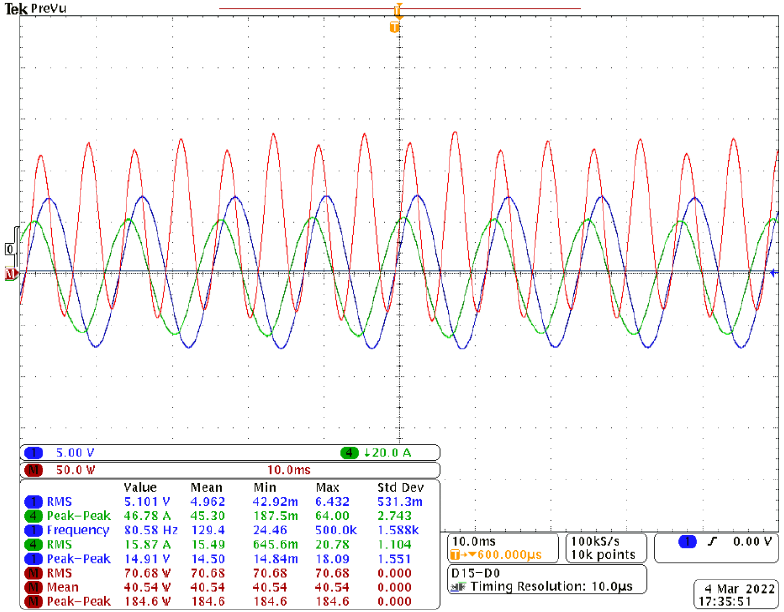
Figure 17. Single phase (26-turns) TFM output power at 400 rpm, low